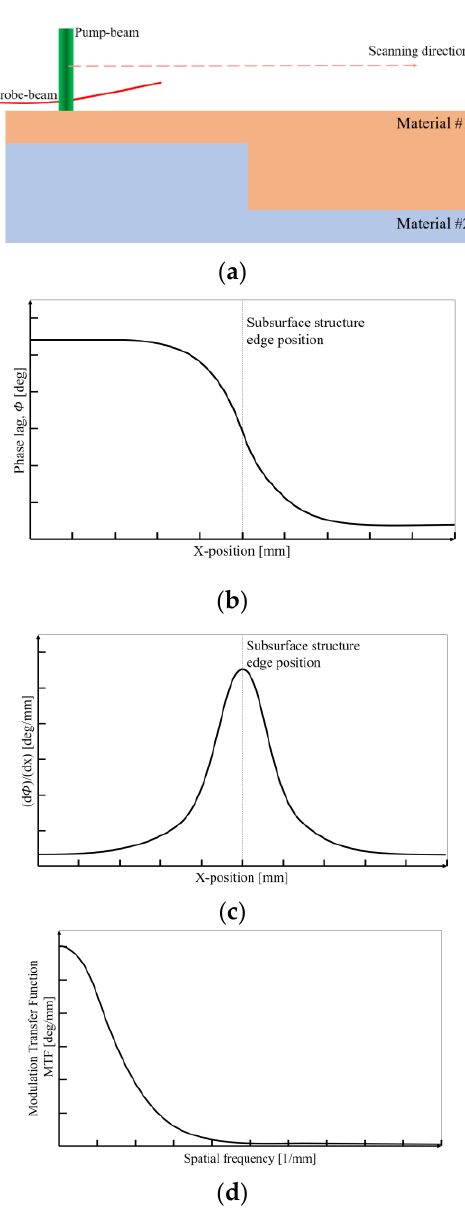
Figure 3. Process of deriving the modulation transfer function (MTF) from the scanning results: ( a ) Signals of specimens with a subsurface structure, ( b ) edge response function (ERF) derived through measurements, ( c ) line spread function (LSF) derived through differentiation, and ( d ) modulation transfer function derived through the fast Fourier transform (FFT).